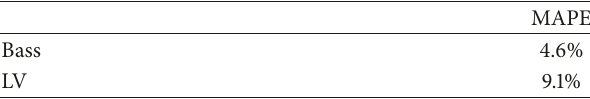
Table 5: MAPE Comparison between LV and Bass model.